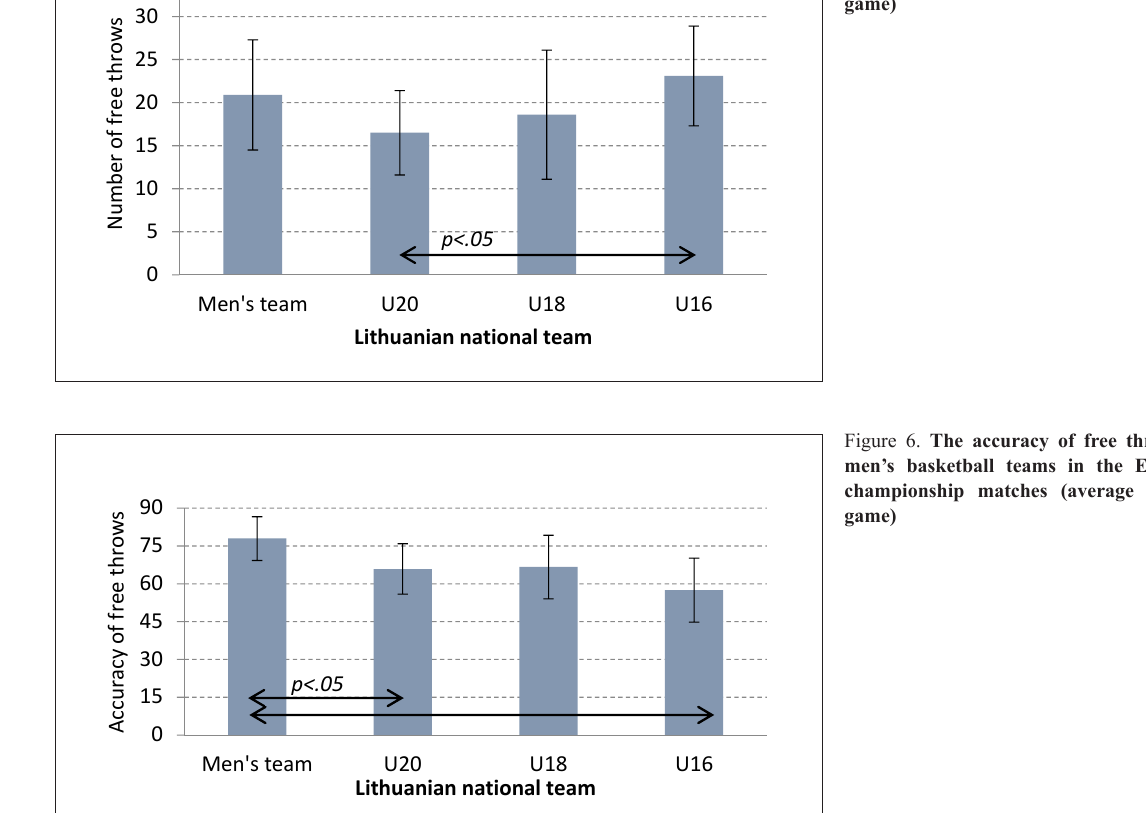
Figure 5. The number of free throws for men’s basketball teams in the European championship matches (average per one game)